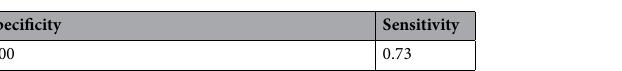
Table 6. Sensitivity and specificity values for the neural network in the web